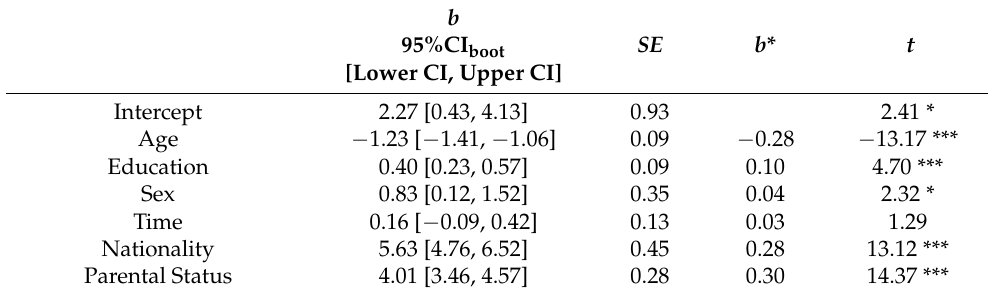
Table 5. Second step of the hierarchical linear regression of parental status on COVID-19 stress